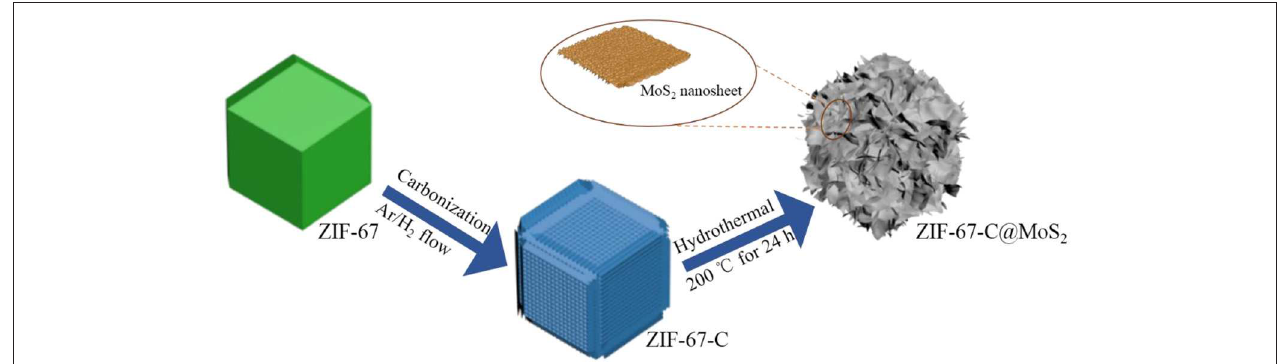
FIGURE 1 | Schematic illustration for the synthesis of ZIF-67-C@MoS 2 nanocomposite.